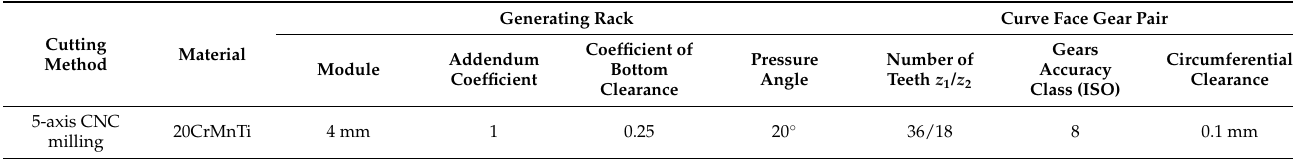
Table 6. Specific properties of the curve face gear pair.